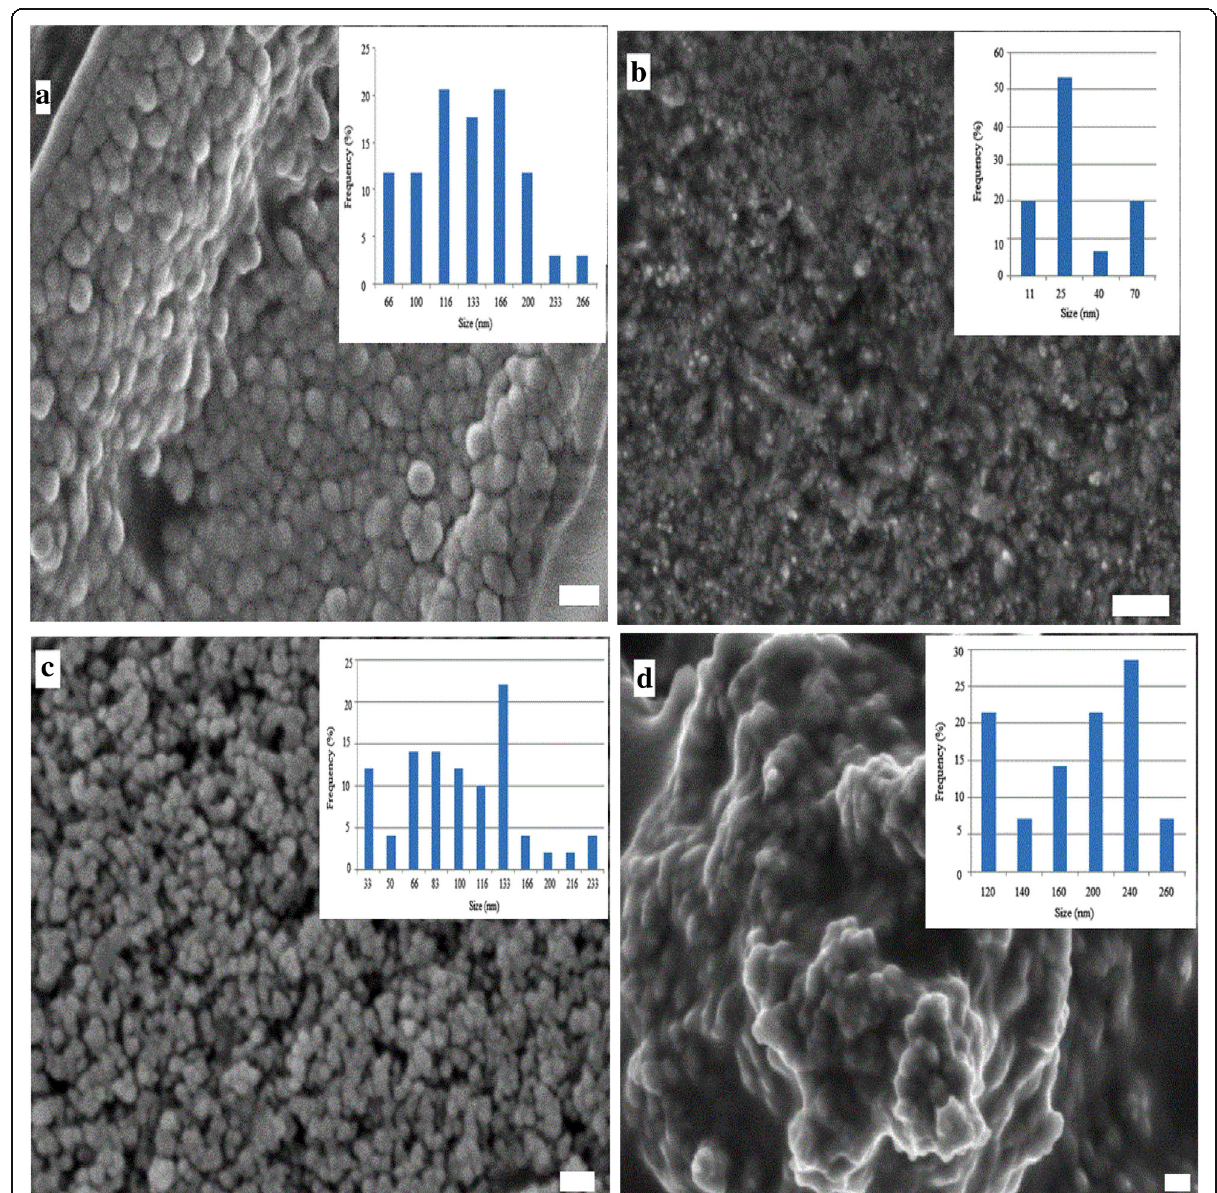
Fig. 1 Scanning electron microscope images and histograms of PNIPAAm ( a ), Fe 3 O 4 -PNIPAAm-1 ( b ), Fe 3 O 4 -PNIPAAm-2 ( c ) and Fe 3 O 4 -PNIPAAm-3 ( d ). Scale bar = 200